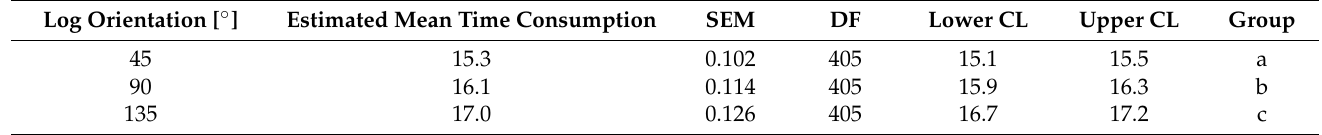
Table 4. Estimated mean time consumption per loading cycle for each log orientation.